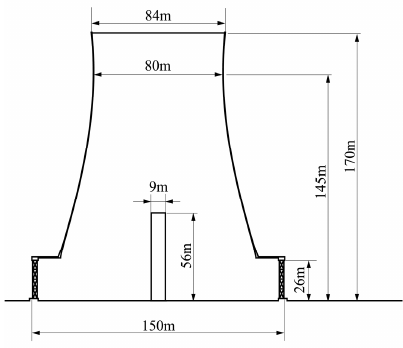
Figure 2. Main dimensions of NDDCT with flue gas injection.